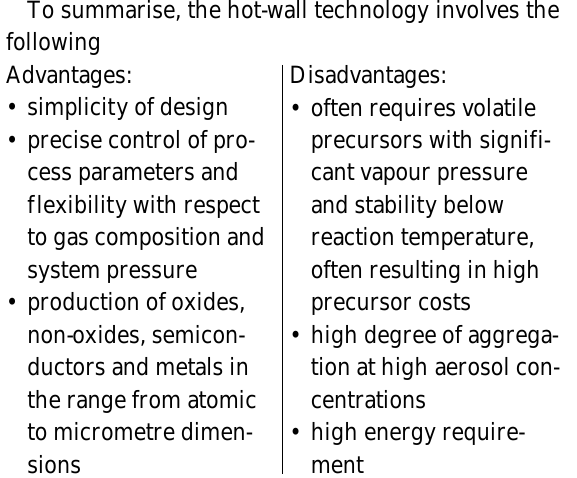
Schematic of the pilot-scale hot-wall reactor operated by the Project House Nanomaterials.